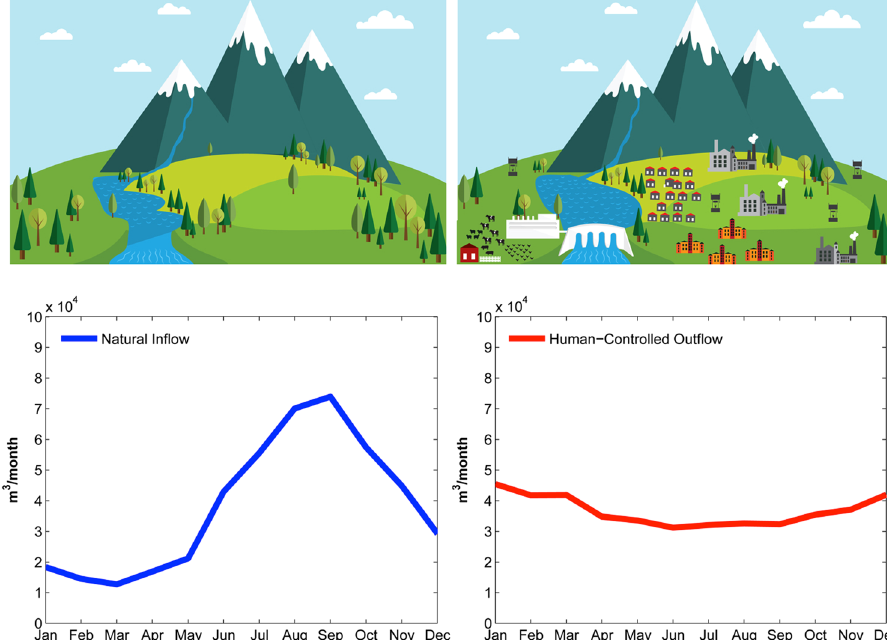
Figure 1. Anthropogenic activities alter the natural water cycle and distribution. The bottom row shows the mean monthly inflow to and outflow from Melbourne major reservoirs: (left) Natural stream flow upstream of the reservoirs before management by man-made infrastructure, (right) human-dominated outflow from the